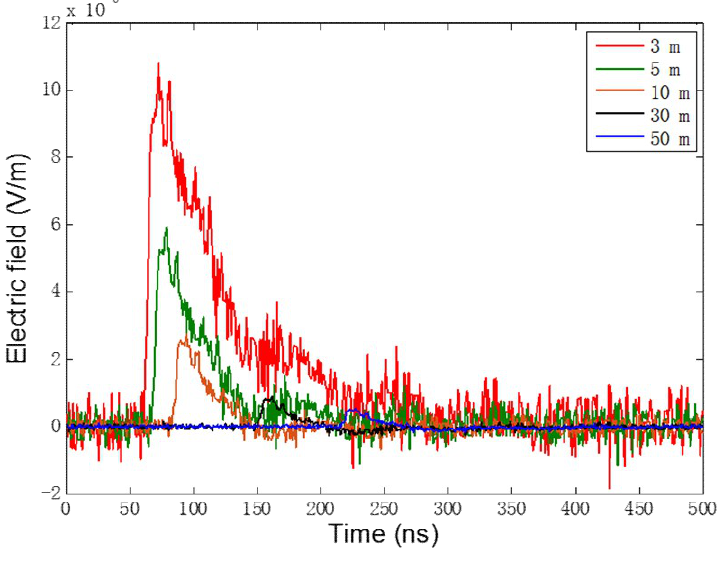
Figure 12. Discharge EM radiation field waveform.